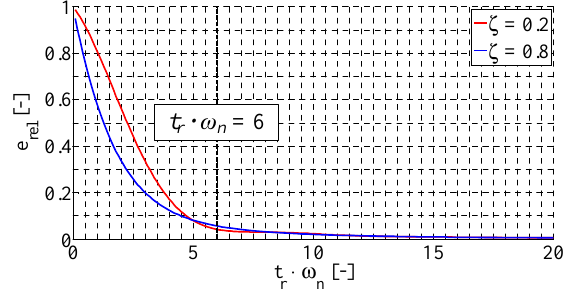
Figure 5: Relative overshoot as function of ramp time for two different damping